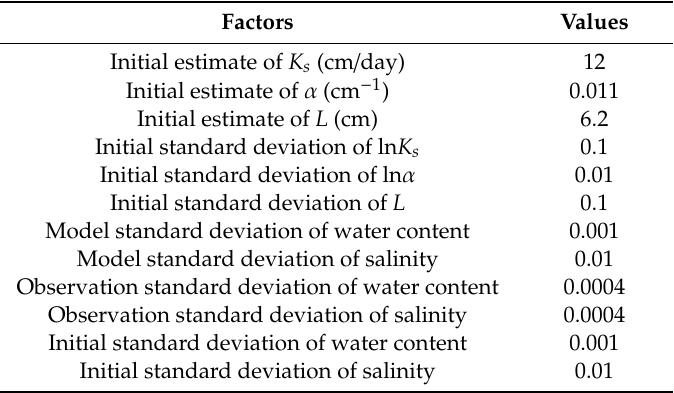
Table 3. Values of potential impact factors for synthetic